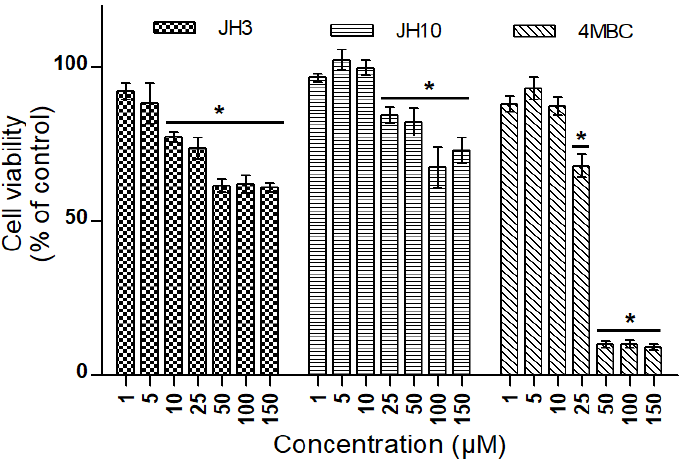
Figure 5. Cell viability in CHO-K1 cells exposed to JH3, JH10, and 4-methylbenzylidene camphor (4MBC) determined by MTT assay. Graph represents percentage of viable cells in comparison to the control condition ± standard deviation (* p < 0.05). Experiment was conducted two times with three repetitions for each condition.